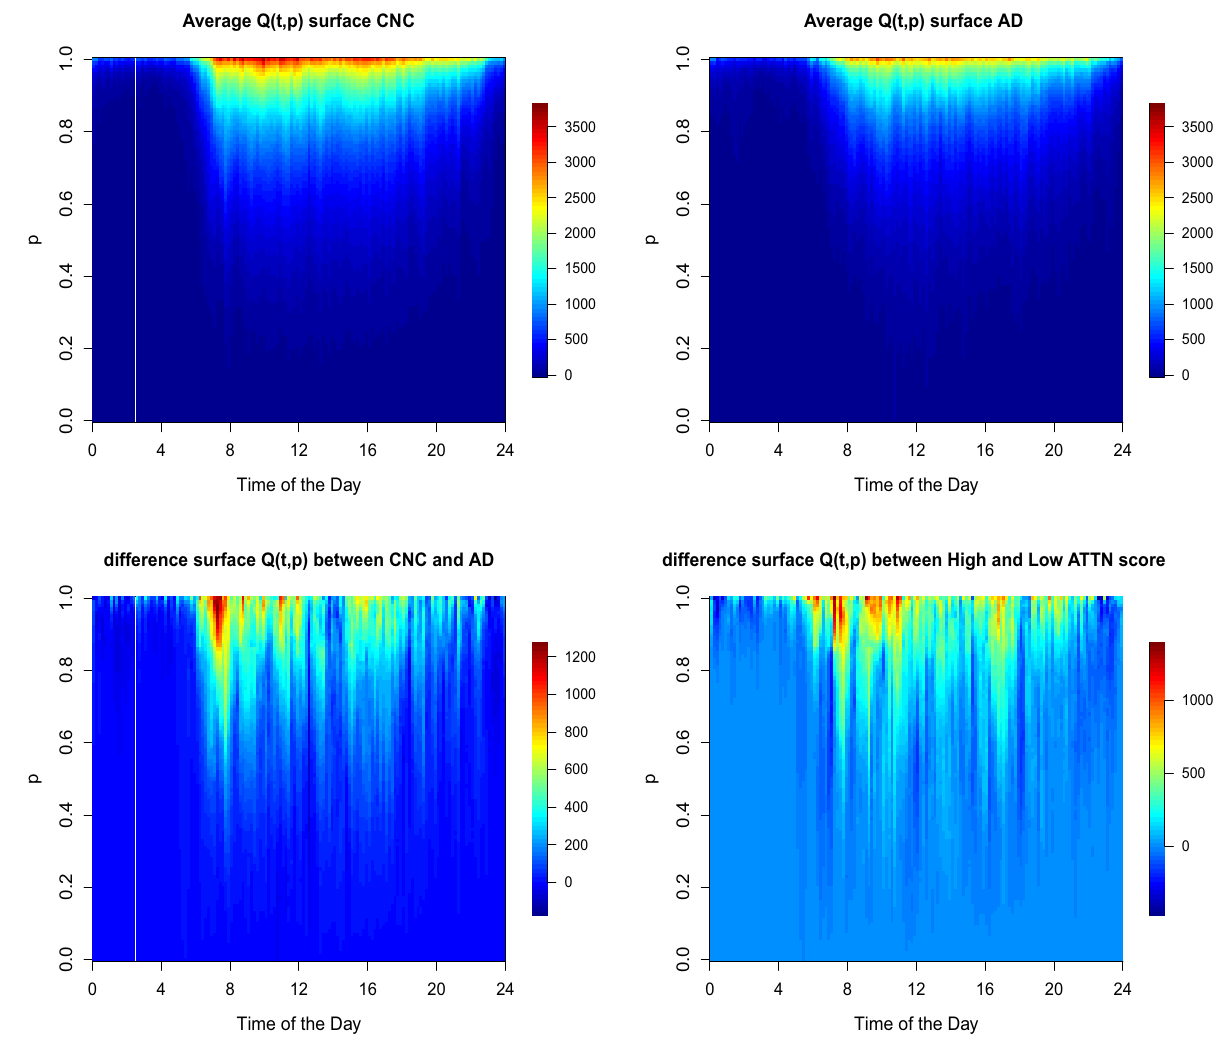
Figure 2. The average bivariate time-by-distribution PA surface Q i ( t , p ) for CNC (top left) and AD (top right) groups. The difference between CNC and AD (bottom left) and the difference between subjects with high (above 75% percentile) and low (below 25% -percentile) of cognitive attention (ATTN) scores (bottom